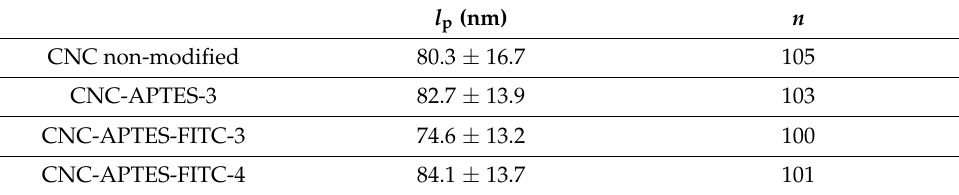
Figure 6. Particle size distribution from TEM imaging. Table 5. Length of particles l p , measured on TEM images ( n : number of measured particles per sample).